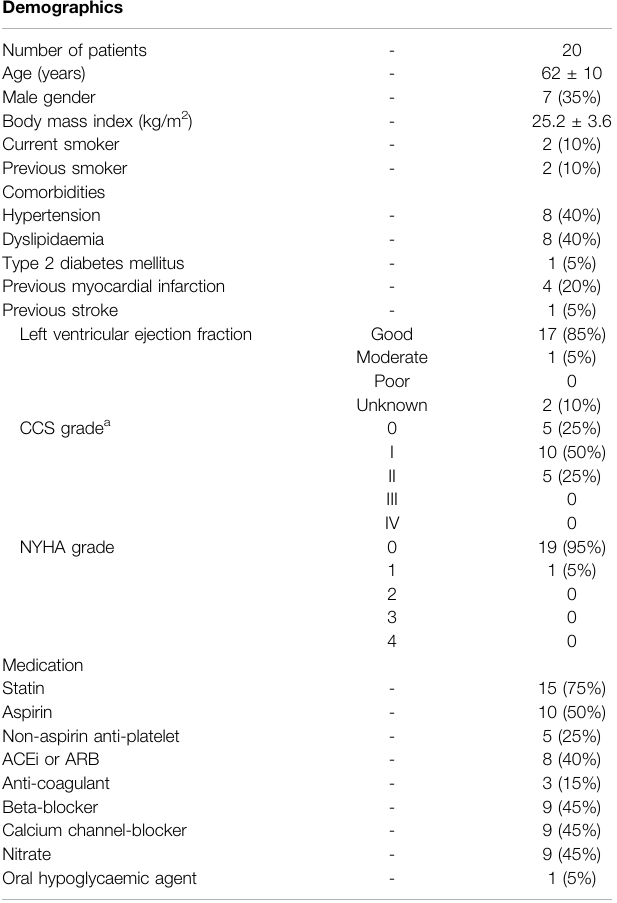
TABLE 1 | Recruited patient